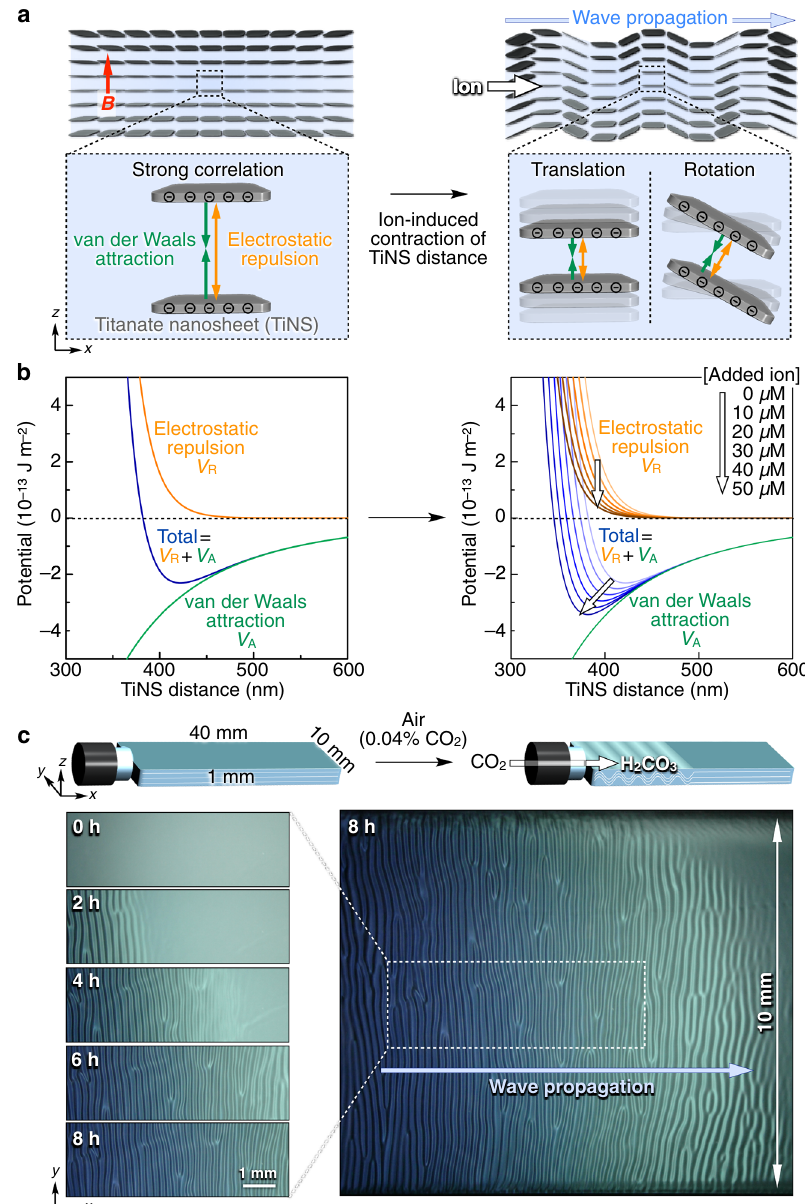
Fig. 1 Autonomously propagating wave generated by the coherent motion of titanate nanosheets (TiNSs) in their aqueous dispersion. a Schematic illustrations of wave propagation by the coherent motion of negatively charged titanate nanosheets (TiNSs). In water, colloidally dispersed TiNSs are strongly correlated with each other, adopting a cofacial geometry with competitive electrostatic repulsion and van der Waals attraction. When a 10T magnetic fi eld is applied to this aqueous dispersion in a quartz cuvette along its z -axis, all the nanosheets align parallel to the xy -plane of the cuvette and form a monodomain cofacial assembly (left). After the magnetic fi eld is turned off, ionic species are added from the open end of the cuvette, generating an ion gradient that progressively attenuates the electrostatic repulsion between TiNSs. Consequently, the van der Waals attraction between TiNSs prevails, thereby causing a contraction of the TiNS distance through their tilting motion. Owing to the strong correlation between TiNSs, this colloidal motion occurs coherently over a large scale, generating a wave, which then propagates unidirectionally along the direction of ion diffusion (right). b Ion-induced contraction of the TiNS distance elucidated by the DLVO theory. Theoretically calculated total potential ( V A + V R ) at different ion concentrations (0.27 – 0.32mM) is plotted as a function of the TiNS distance. When ionic species are added to the colloidal dispersion, the electrostatic repulsion between TiNSs is attenuated due to the screening effect, thereby reducing the TiNS distance at the local minimum of the potential. c Time-dependent optical images of a magnetically oriented TiNS dispersion ([TiNS] = 0.5wt%) in a quartz cuvette (40×10×1mm) at 25°C in air (0.04% CO 2 ) after turning off the magnetic fi